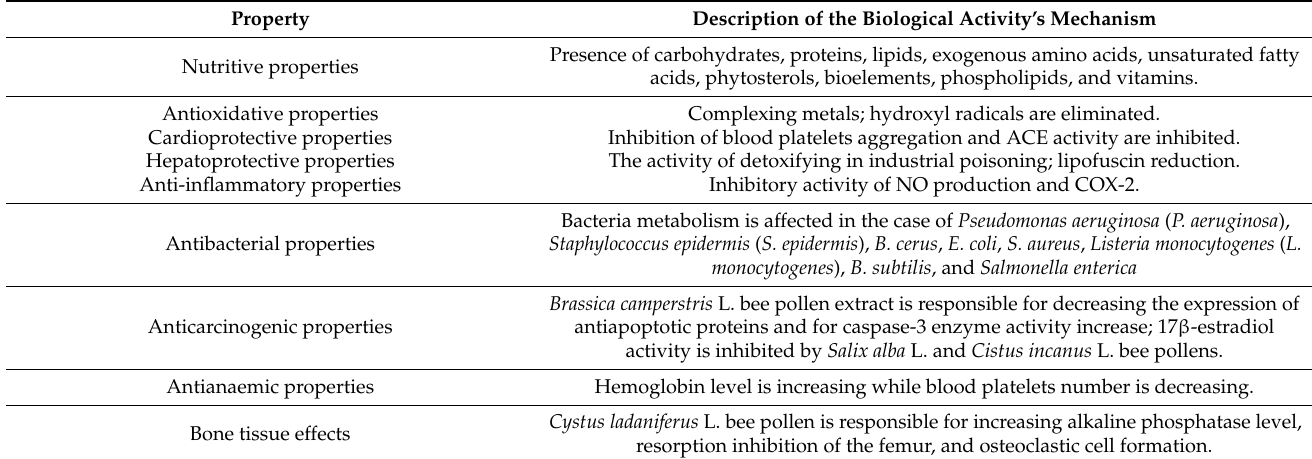
Table 3. Bee pollen—the biological properties and main mechanisms (Reprinted from